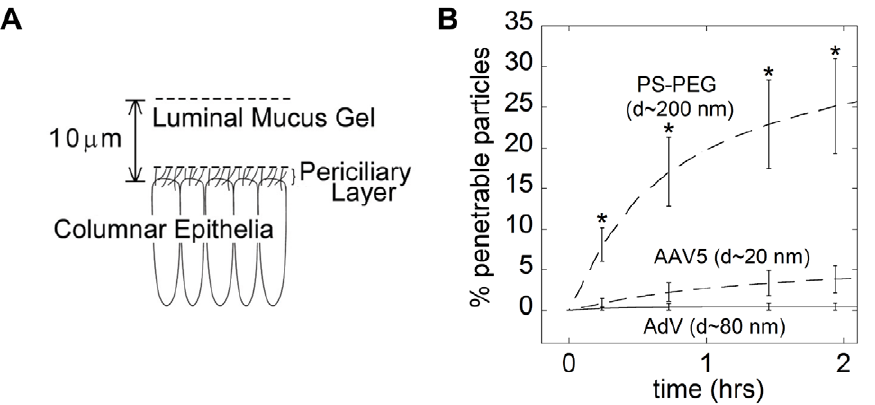
Figure 5. Theoretical model of particle penetration across a sputum layer. (A) S chematic of the model, where particles are deposited in airway lumen on top of the CF sputum layer and must penetrate a 10 m m sputum layer to reach the epithelial cells. The pericilliary layer is much smaller in CF patients due to the collapsed cilia from the accumulated sputum [60]. (B) Estimated fraction of viral and synthetic particles that are capable of penetrating a 10 m m thick layer of CF sputum over time using Fick’s second law. *Statistically significant difference when compared with AAV5, AdV or PS (p , 0.05).